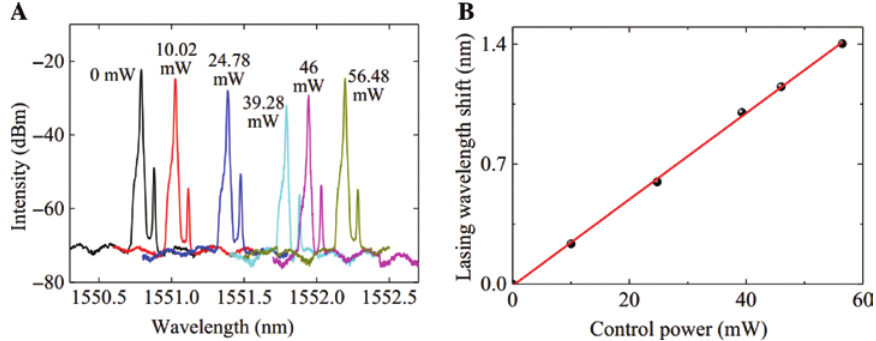
Figure 7: Tuning performance of the Brillouin microlaser. (A) Brillouin lasing spectra (including the reflected pump light and the first-order Stokes light) for different control powers. (B) Lasing wavelength shift as a function of the control